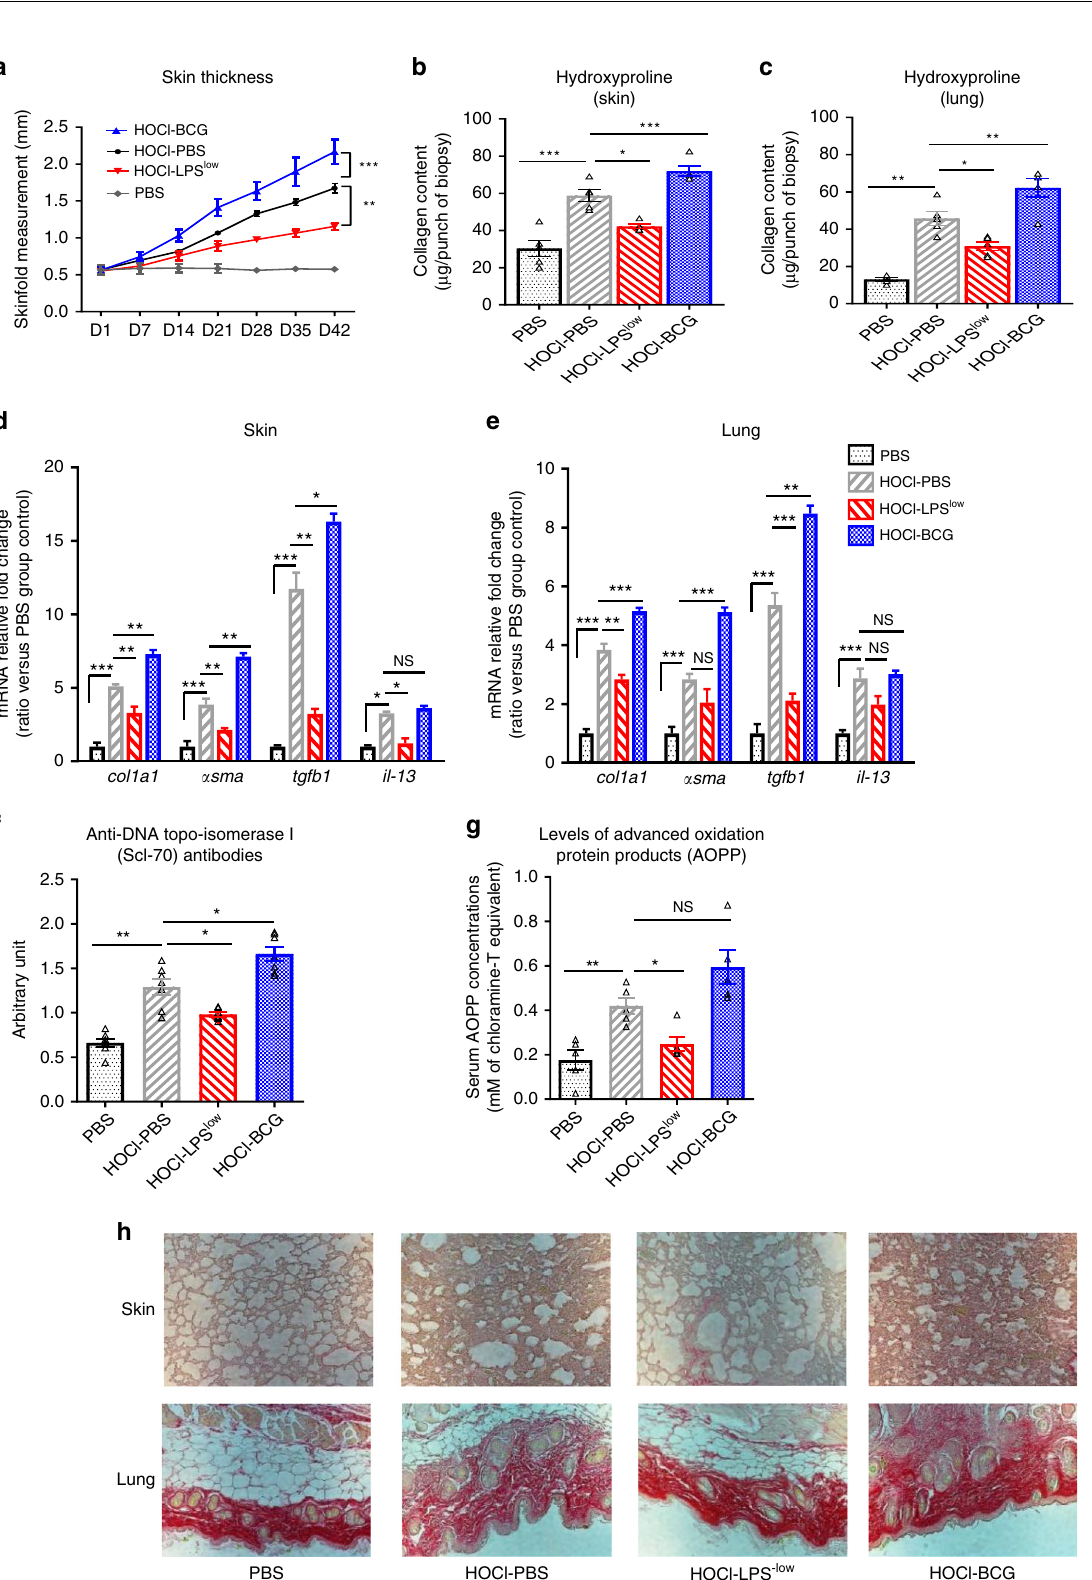
of variation was observed in lungs, although not signi fi cant with LPS low -macrophages compared to HOCl-mice (Fig. 5d). In (Supplementary Fig. 6a). the lung, treatment with BCG-treated macrophage induced an Fibrosis markers correlated with the clinical fi ndings as we overexpression of Tgfb1 and a trend toward an increase of α -sma observed a signi fi cant increase of α -sma , Col1a1 , and Tgfb1 (Supplementary Fig. 6b), while administration of LPS low -macro- phages downregulated these two markers. Seric circulating anti- mRNA expression in the skin of mice treated with BCG- Scl70 antibodies and AOPP levels showed a similar pro fi le macrophages, while these markers were decreased in mice treated NATURE COMMUNICATIONS| (2019) 10:5670